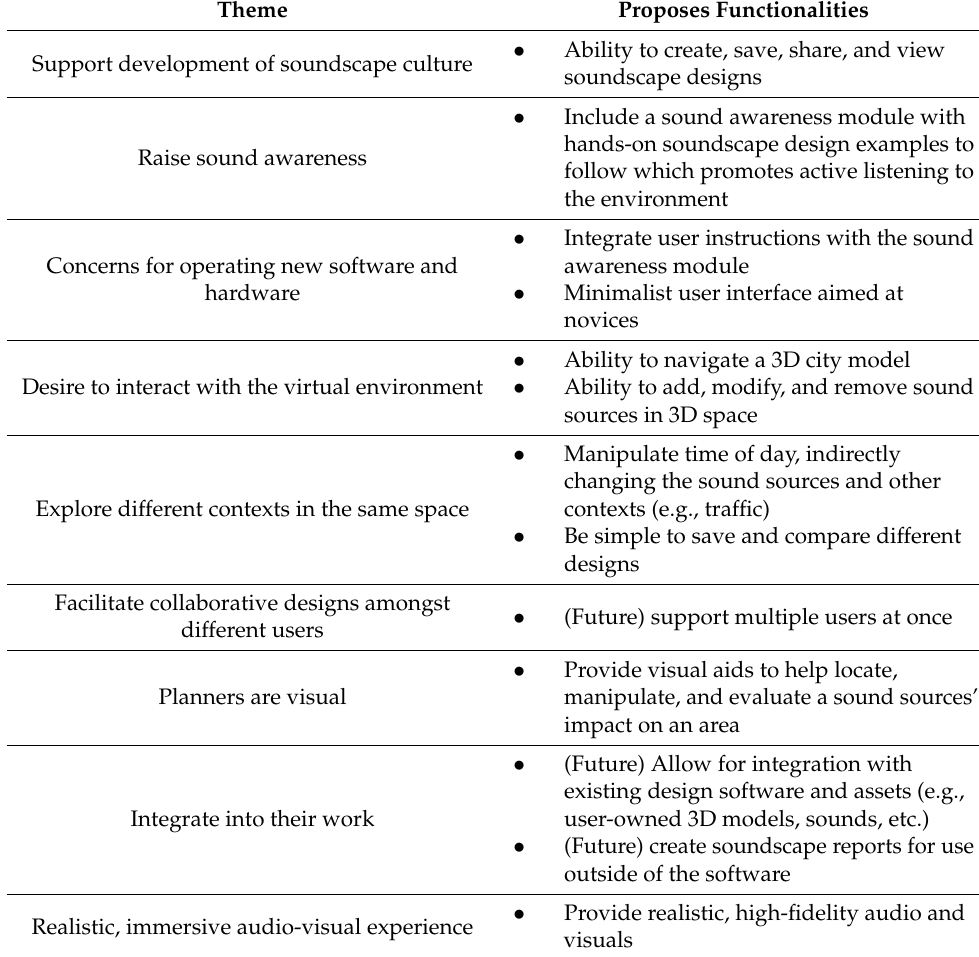
Table 1. Proposed functionalities, drawn from